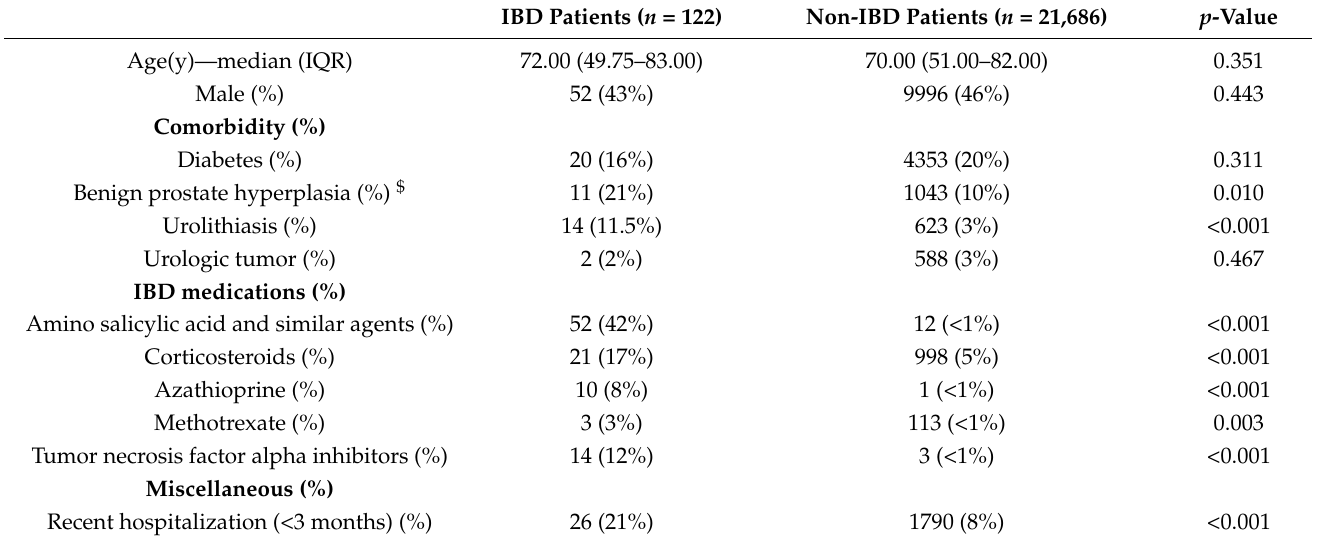
Table 1. Baseline characteristics: IBD patients vs. non-IBD patients.